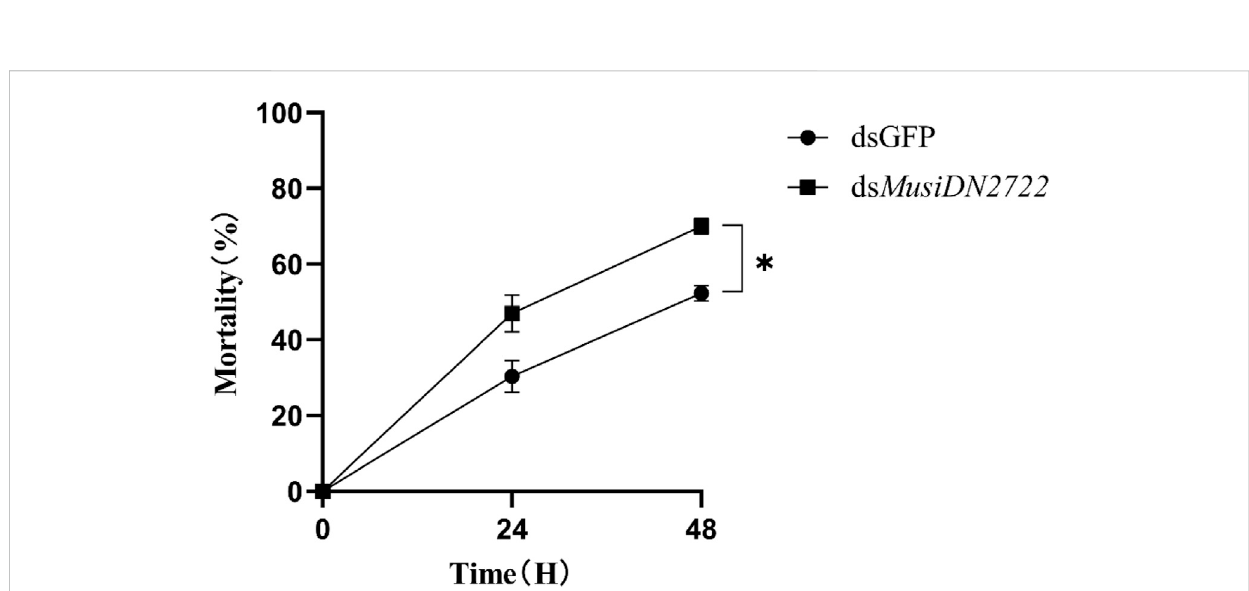
FIGURE 8 Mortality following dsRNA interference, 24 h and 48 h after treatment with acetamiprid LC 50 . Data are represented in the form mean ± SEM. *signi fi cant difference ( p < 0.05).